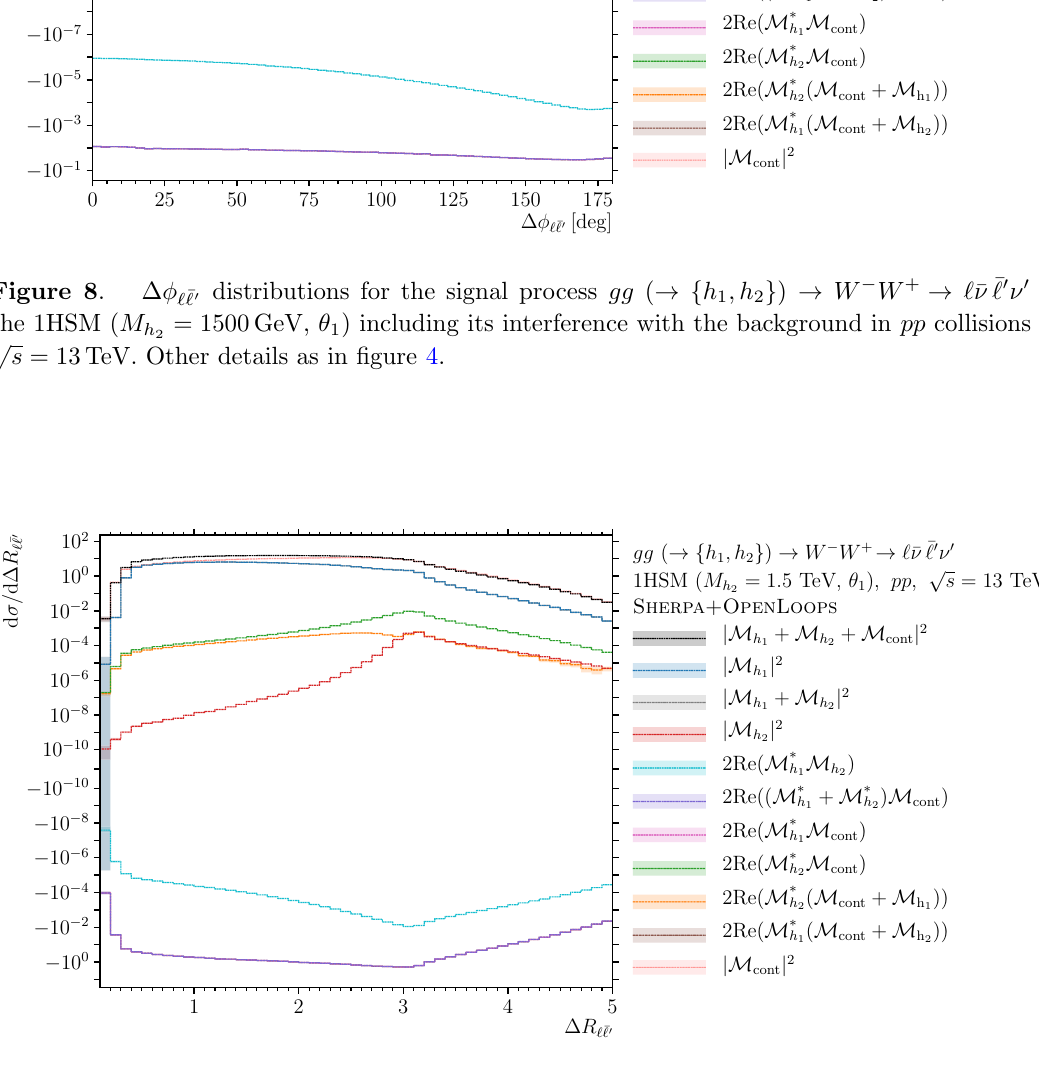
h 1 , h 2 ) W − W + (cid:26) ¯ ν ¯ (cid:26) (cid:30) ν (cid:30) in → { } → →